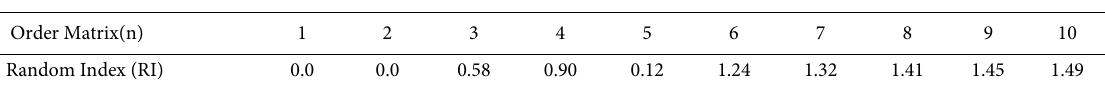
Table 5: Random index